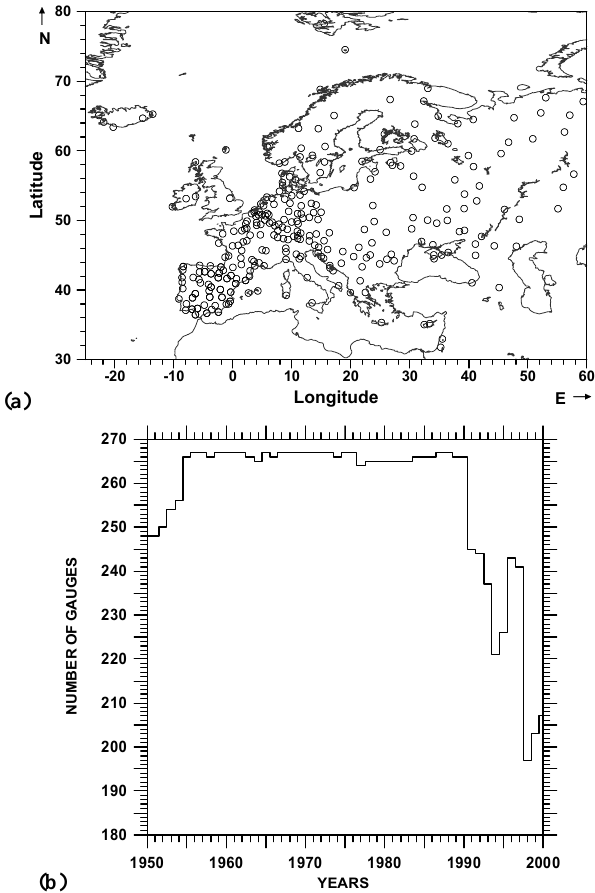
Fig. 1. (a) Spatial distribution of the 267 rain gauges in Europe. (b) Number of available records per year along the recording